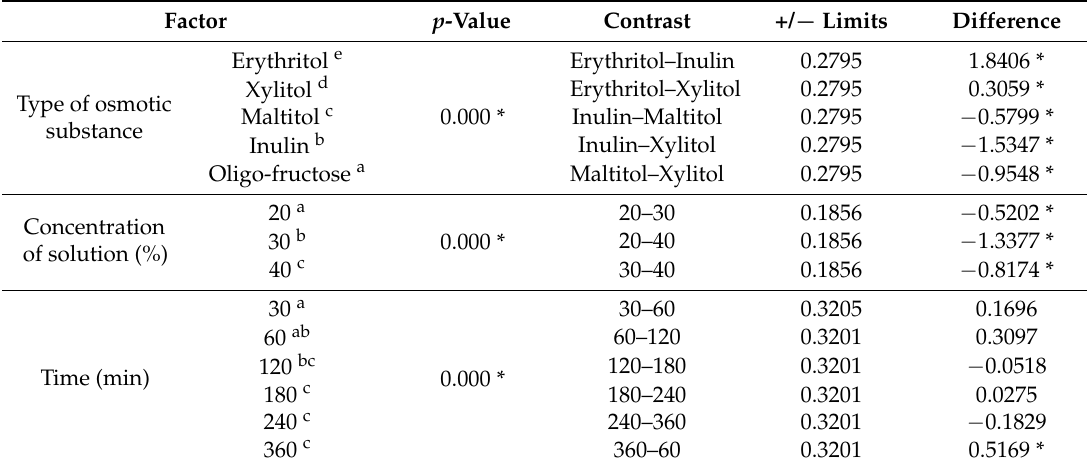
Table 5. The influence of osmotic pre-treatment in different types, concentrations of solutions, and time on WL (g/g i.d.m.) during